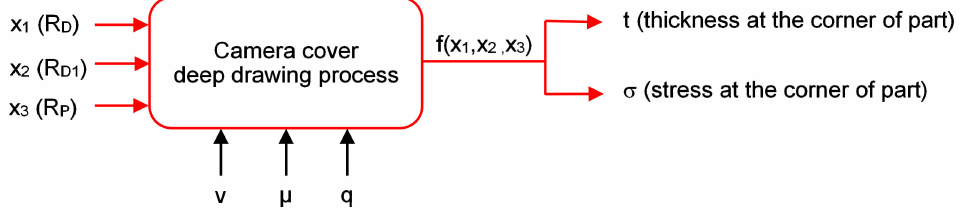
Figure 10. The schematic for the numerical and experimental